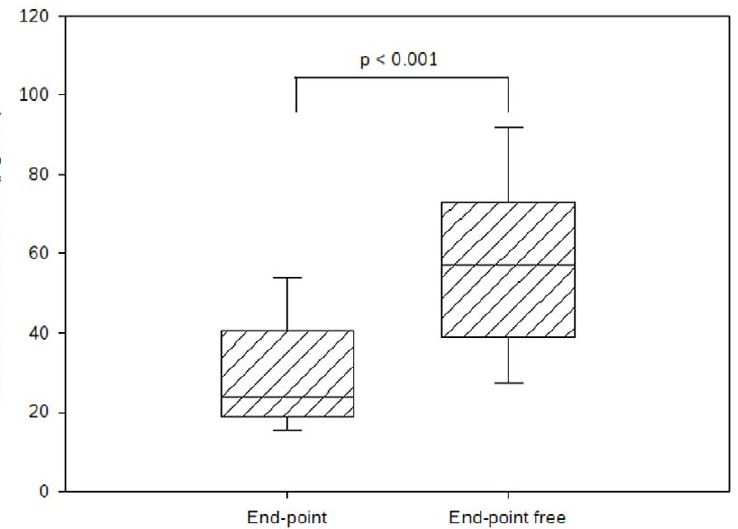
Figure 1. Serum concentration of soluble TRAIL. Data are expressed as median with interquartile ranges. Statistical comparison was done by Wilcoxon test.